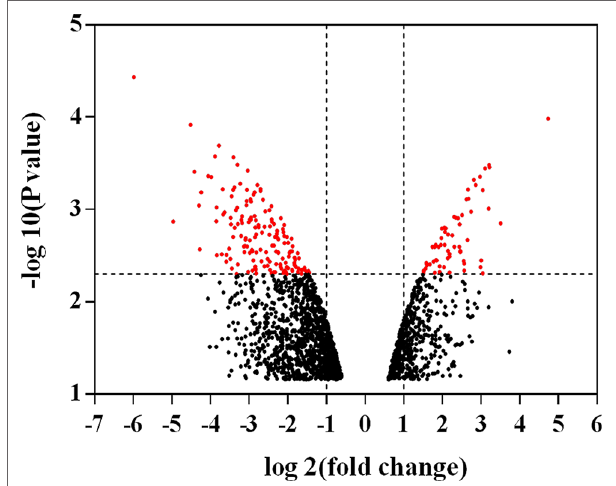
FIgUrE 1 | Volcano plot of differentially expressed genes. The abscissa represents the fold changes in gene expression and the ordinate represents the statistical significance of the variations in gene expression. The red dots represent significantly differentially expressed